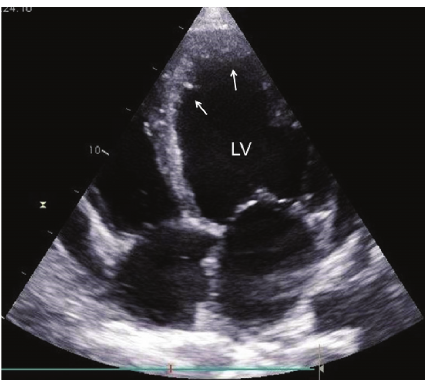
Figure 1: Echocardiographic apical 4-chamber view showing an enlarged left ventricle (LV) with hypertrabeculation/noncompaction affecting the left ventricular apex, the apical septum, and lateral wall (arrows).